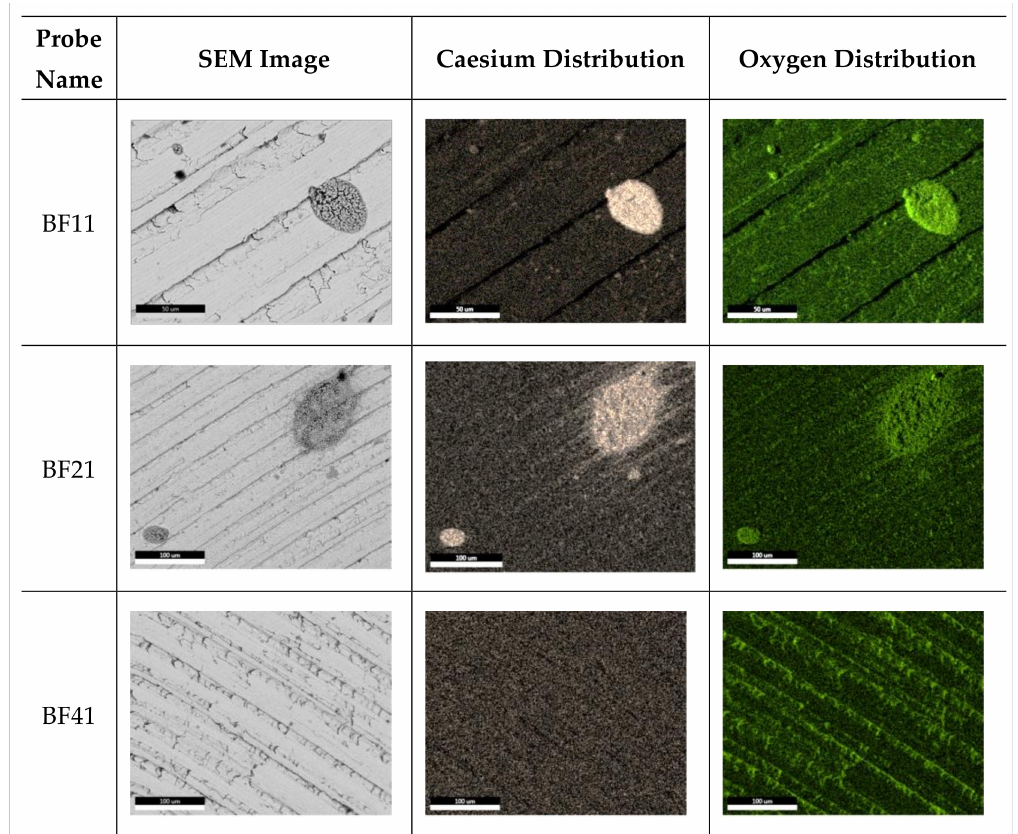
Figure 9. Compositional map of Cs and O on probes BF11, BF21 and